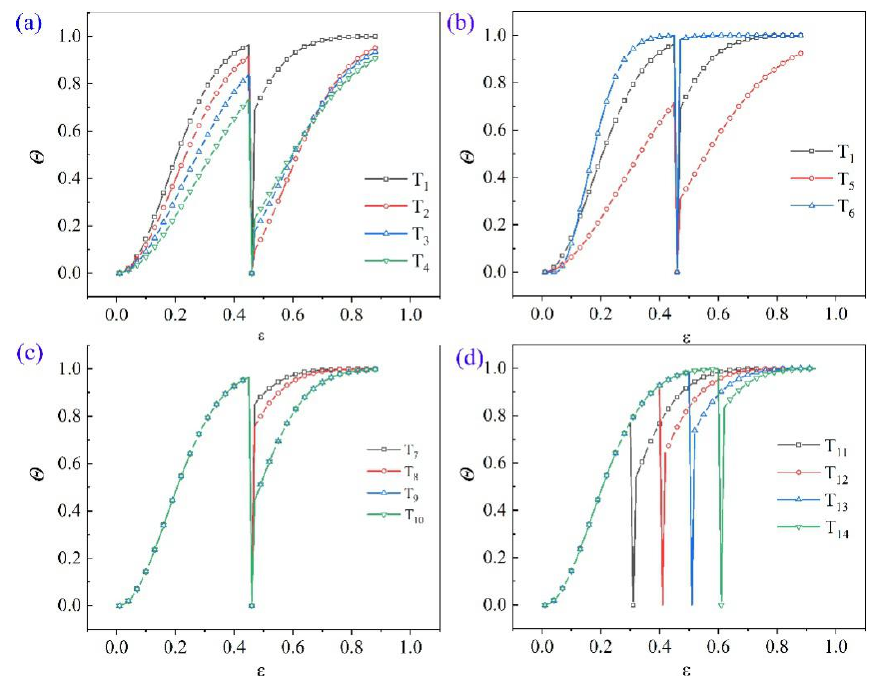
Figure 10. Softening fraction in double-pass compressions. ( a ) T 1 –T 4 , ( b ) T 1 , T 5 , and T 6 , ( c ) T 7 –T 10 , ( d ) T 11 –T 14.